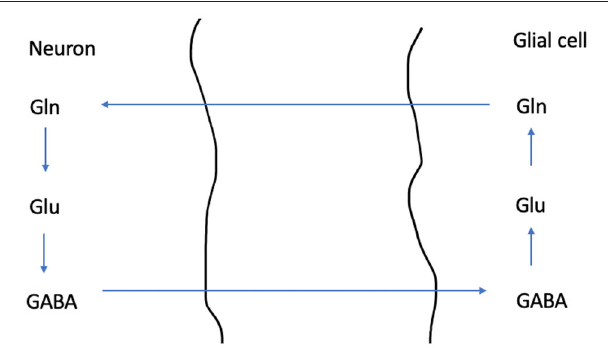
FIGURE 3 | A schematic overview illustrating the Glutamine - Glutamate- GABA cycle. GABA is the most common inhibitory neurotransmitter in our nervous system, while Glutamate is the most common excitatory neuro transmitter. Cells where glutamate is synthetized from glutamine are glutamatergic, while cells where this pathway ends in synthesis of GABA are GABAergic. Glutamine is synthetized in the glial cell, and is then transported into the neuron. In the neuron’s mitochondria glutamate is synthetized from glutamine. Then glutamate is stored in synaptic vesicles (not shown). Alternatively, GABA can be synthetized from